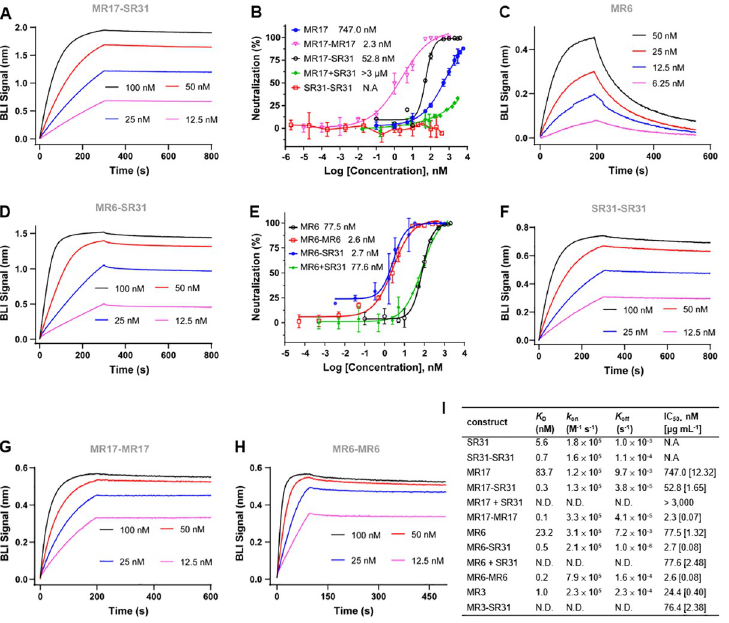
Fig 6. SR31 increases binding affinity and neutralization activity of two fusion partners. ( A ) BLI binding assay with immobilized RBD and the biparatopic sybody MR17-SR31 as analyte at increasing concentrations (nM). ( B ) Neutralization assay of MR17 (blue), MR17-MR17 (magenta), MR17-SR31 (black), the equimolar mix of MR17 and SR31 (MR17+SR31, green), and SR31-SR31 (red). ( C, D ) Binding kinetics for the RBD-binding by MR6 ( C ) or by MR6-SR31 ( D ). ( E ) Neutralization assay of MR6 (black), MR6-MR6 (red), MR6-SR31 (blue), and the equimolar mix of MR6 and SR31 (MR6+SR31, green). ( F, G, H ) BLI binding assay with immobilized RBD and the monoparatopic divalent sybody SR31-SR31 ( F ), MR17-MR17 ( G ), or MR6-MR6 ( H ) as analyte at increasing concentrations (nM). ( I ) Summary of the comparison between monovalent sybodies, SR31-fusion (biparatopic) sybodies, homo-fusion (monoparatopic) sybodies for binding kinetics and neutralization activities. Binding kinetics and neutralization data for MR17 and MR3 are from reference [35]. N.D., not determined; N.A., not applicable. In B and E , data are mean ± standard deviation from three independent experiments, and the x-axis indicates the concentration of the individual sybodies as opposed to the total sybody concentration.